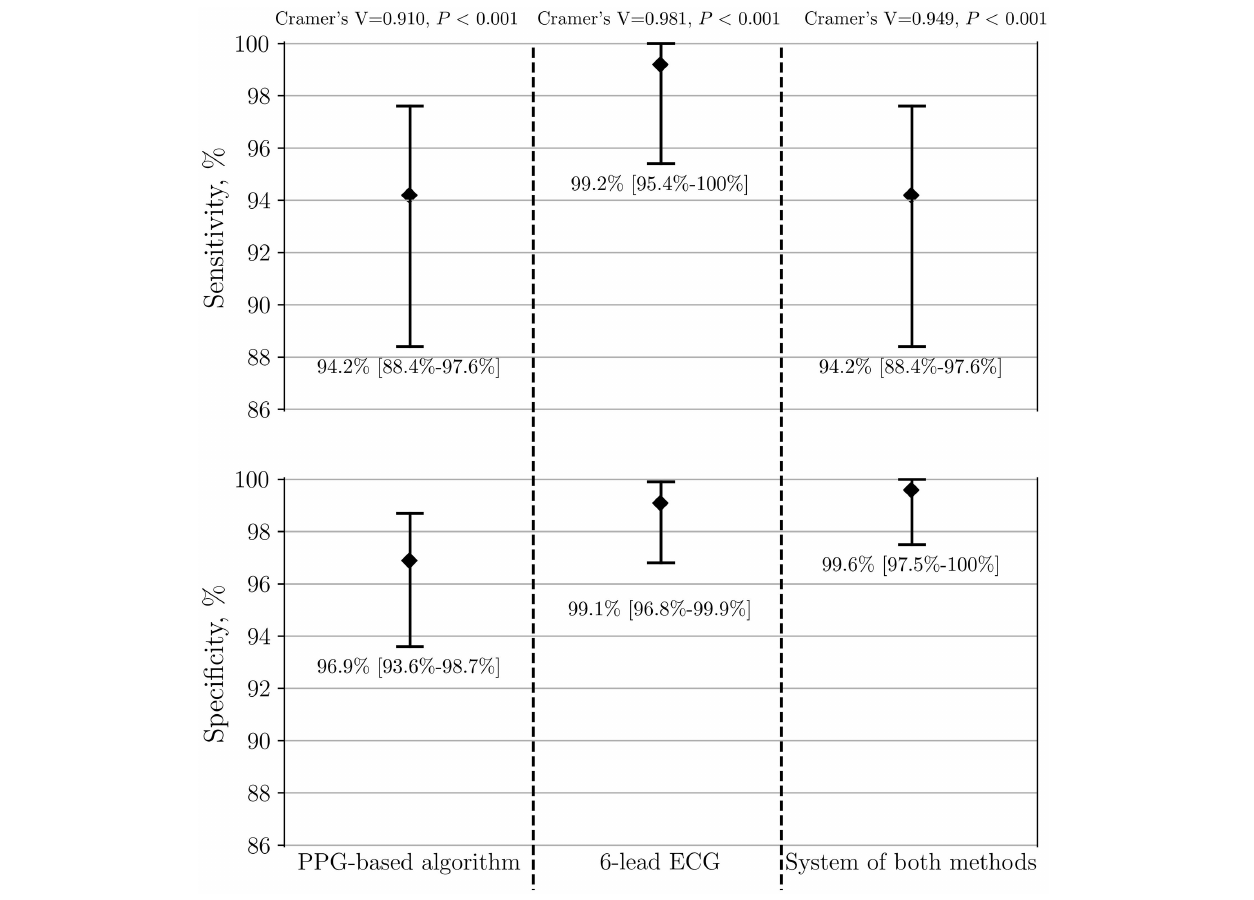
FIGURE 6 | Performance of PPG-based algorithm, 6-lead ECG and the system of both methods to detect AF ( n = 341). The group of AF is compared to both control SR groups, including patients with frequent PVCs/PACs. PPG, photoplethysmography; ECG, electrocardiography; AF, atrial fibrillation; SR, sinus rhythm; PVC, premature ventricular contraction; PAC, premature atrial